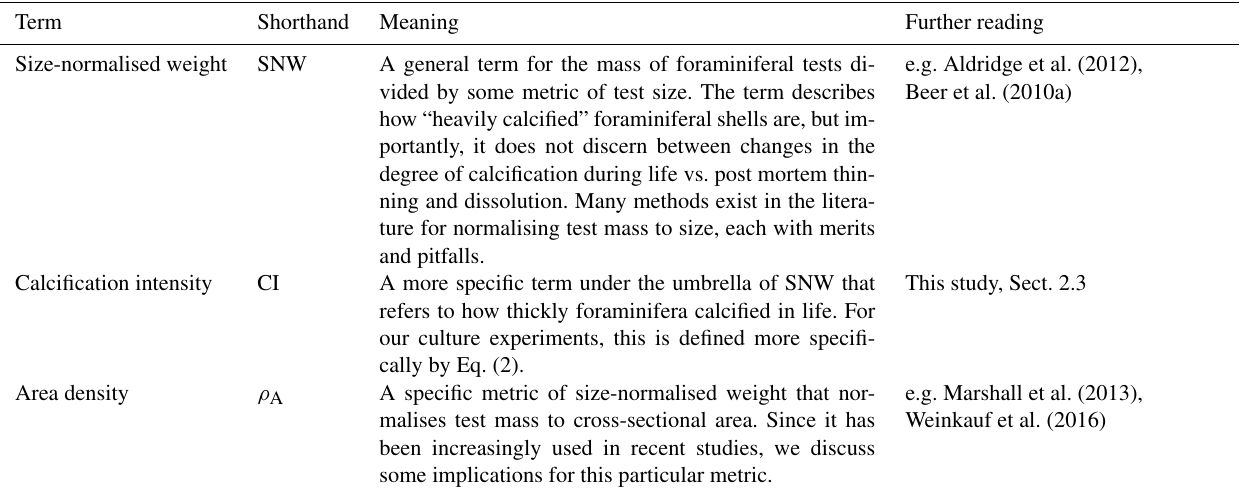
Table 1. Description of important terms used in this paper and the relevant literature. Term Shorthand Meaning Further reading Size-normalised weight SNW A general term for the mass of foraminiferal tests di- vided by some metric of test size. The term describes how “heavily calcified” foraminiferal shells are, but im- portantly, it does not discern between changes in the degree of calcification during life vs. post mortem thin- ning and dissolution. Many methods exist in the litera- ture for normalising test mass to size, each with merits and pitfalls. CI A more specific term under the umbrella of SNW that refers to how thickly foraminifera calcified in life. For our culture experiments, this is defined more specifi- cally by Eq. (2). ρ A A specific metric of size-normalised weight that nor- malises test mass to cross-sectional area. Since it has been increasingly used in recent studies, we discuss some implications for this particular